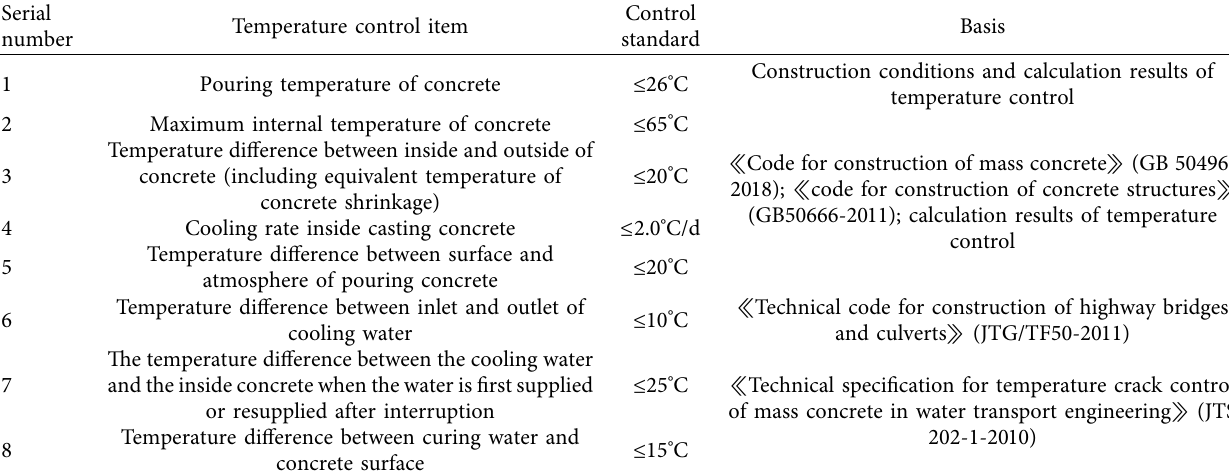
Table 5: Temperature control standard of